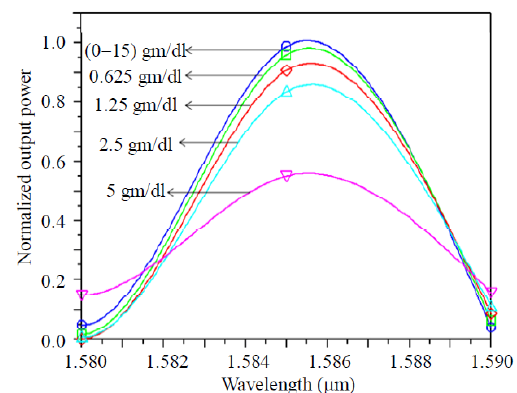
Fig. 6 Normalized output power for different glucose concentrations in urine.